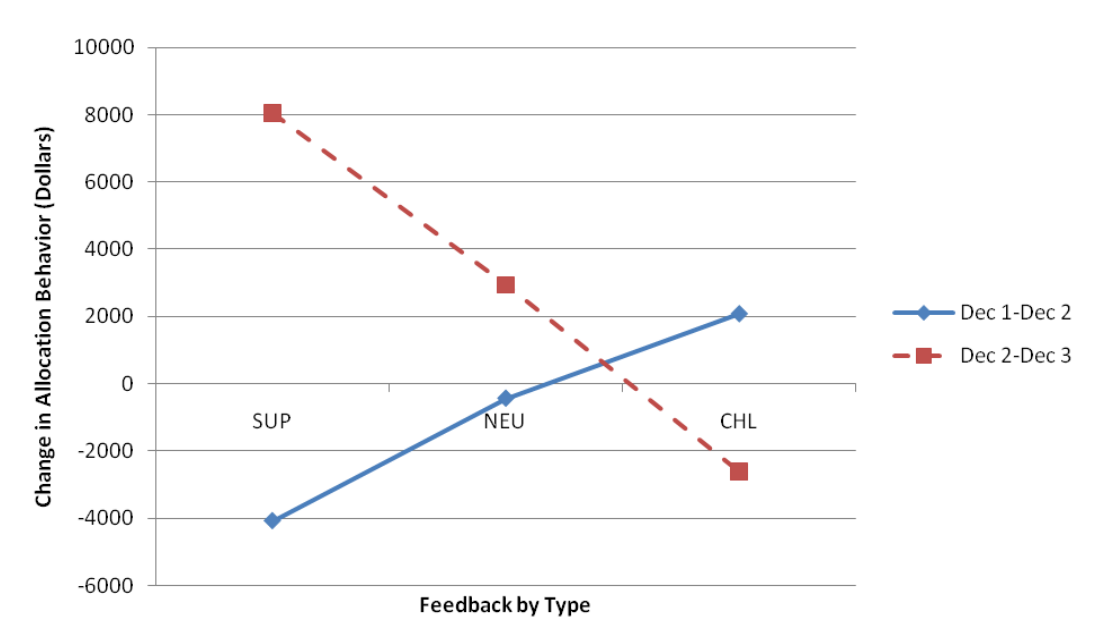
Figure 4. The Effect of Feedback Type on Allocation Behavior between